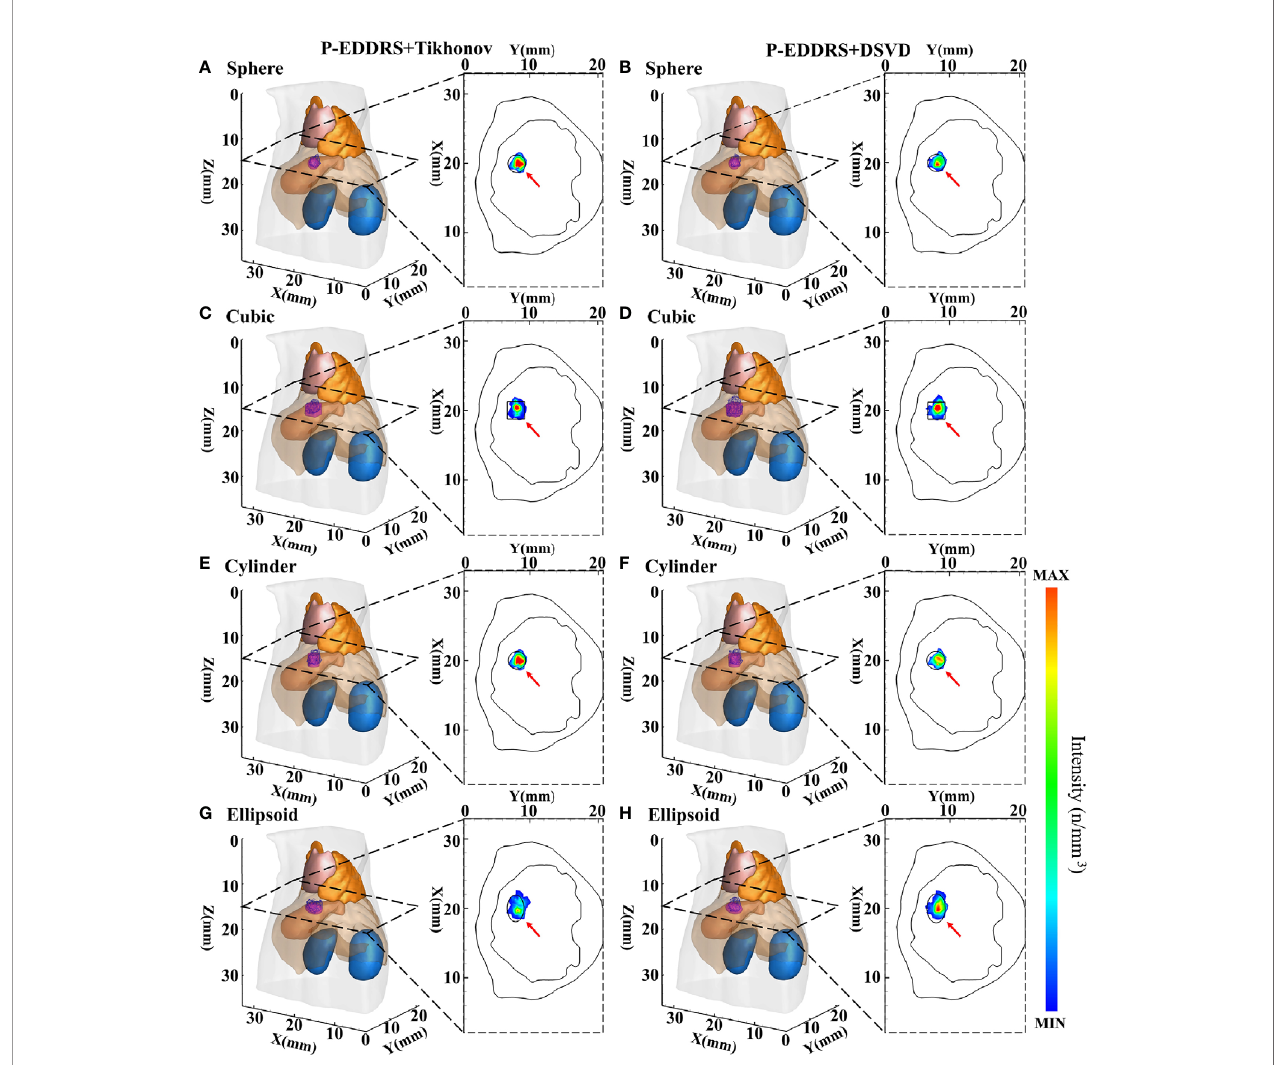
FIGURE 7 | Results of P-EDDRS framework stability and robustness experiment II. All results include 3D views and corresponding cross-section views at the plane of Z = 15 mm (A, C, E, G) . The reconstruction source distribution of different shapes with sphere, cubic, cylinder, and ellipsoid combined with Tikhonov algorithm in our framework, respectively (B, D, F, H) . The reconstruction source distribution of different shapes with sphere, cubic, cylinder, and ellipsoid combined with DSVD algorithm in our framework, respectively. P-EDDRS, probabilistic energy distribution density region scaling; DSVD, damped singular value